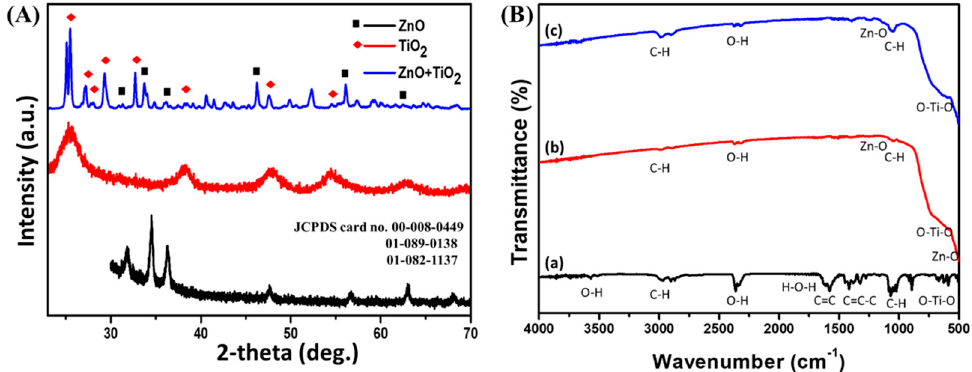
Figure 3. ( A ) X - ray diffraction patterns of ZnO – TiO 2 , ZnO, and TiO 2 and ( B ) Fourier - transform in- frared spectra of ( a ) ZnO – TiO 2 – TEA, ( b ) ZnO – TiO 2 and ( c ) ZnO–TiO 2 –silane